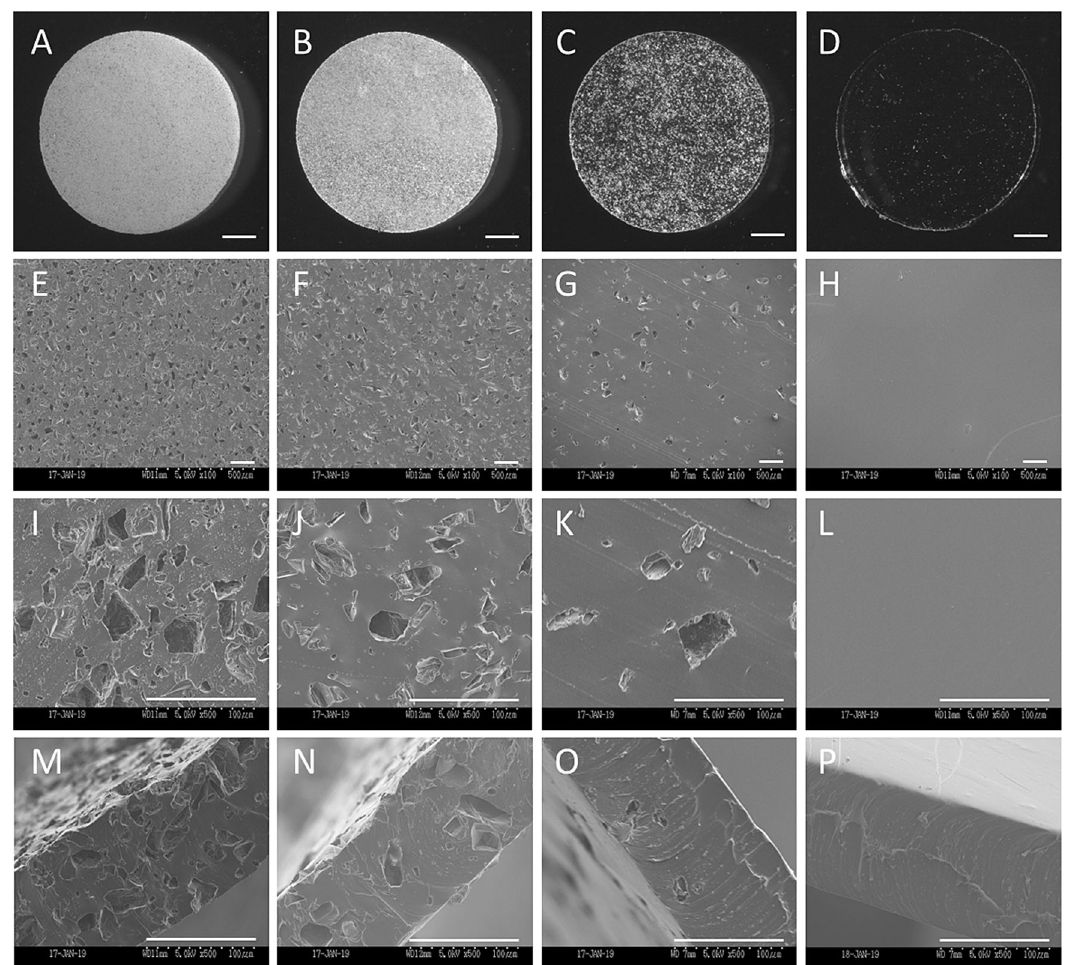
Fig. 2 Representative images of the surface of the porous PDMS sheet with NaCl particle concentration of ( A ) 0.8, ( B ) 0.5, ( C ) 0.1, and ( D ) 0 g/mL. Bars: 1 mm. Representative scanning electron microscopic images of the surface of the porous PDMS sheet with NaCl particle concentration of ( E , I ) 0.8, ( F , J ) 0.5, ( G , K ) 0.1, and ( H , L ) 0 g/mL at